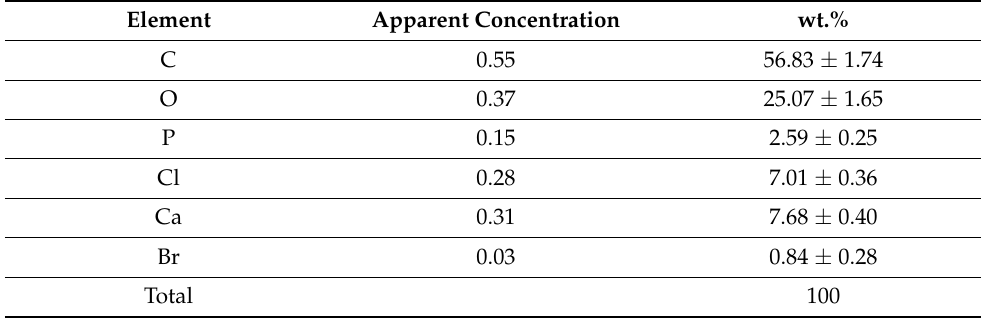
Table 1. EDX data obtained from elemental analysis of adsorbent